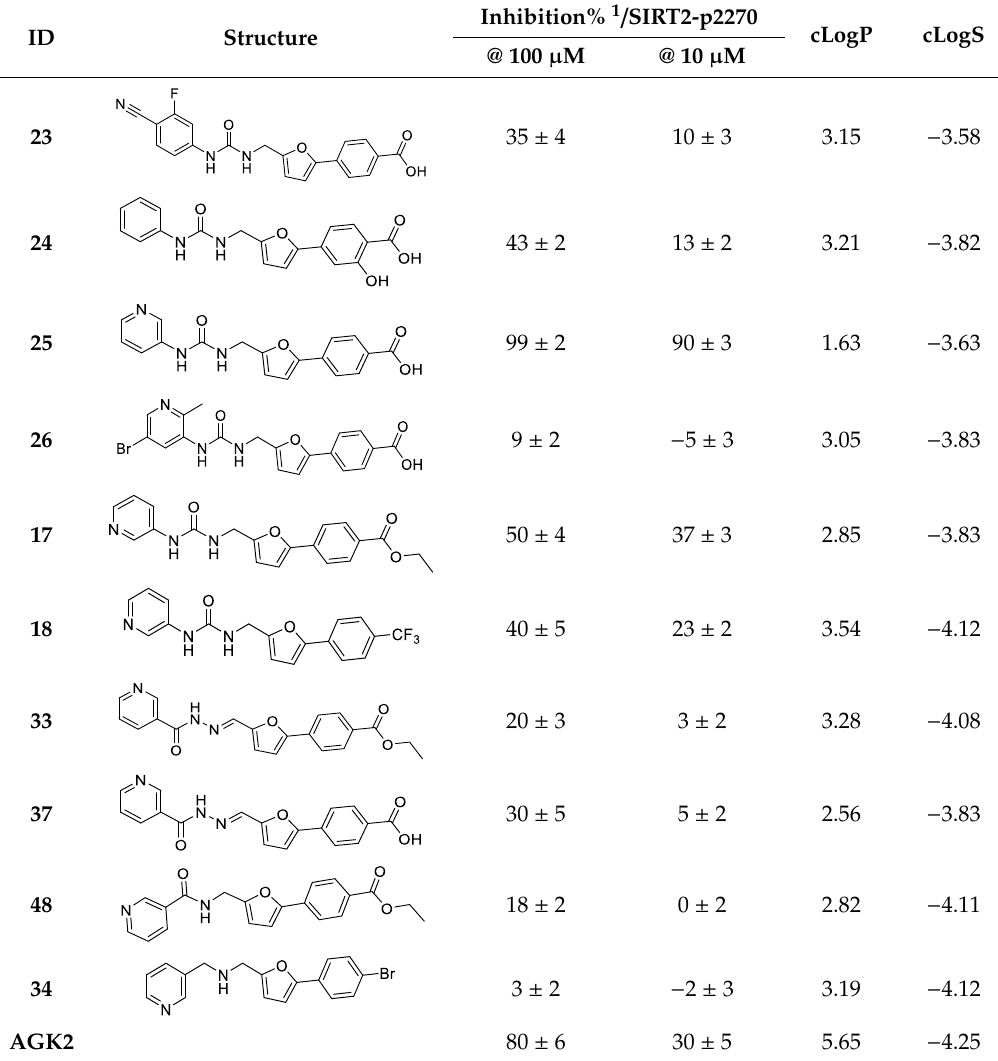
Table 2. The inhibitory activities and calculated clogP/clogS values of compounds 17 – 18 , 23 – 26 , 33 – 34 , 37 and 48 against human SIRT2.